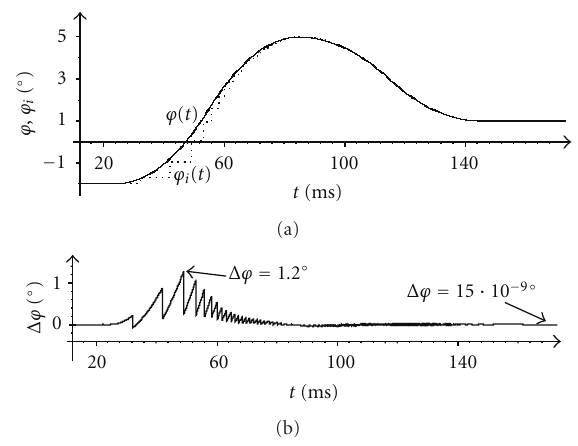
Figure 8: Simulation results: ϕ : actual signal-phase time waveform, ϕ i : signal-phase time waveform measured using the proposed macromodel, and Δ ϕ : phase-error time